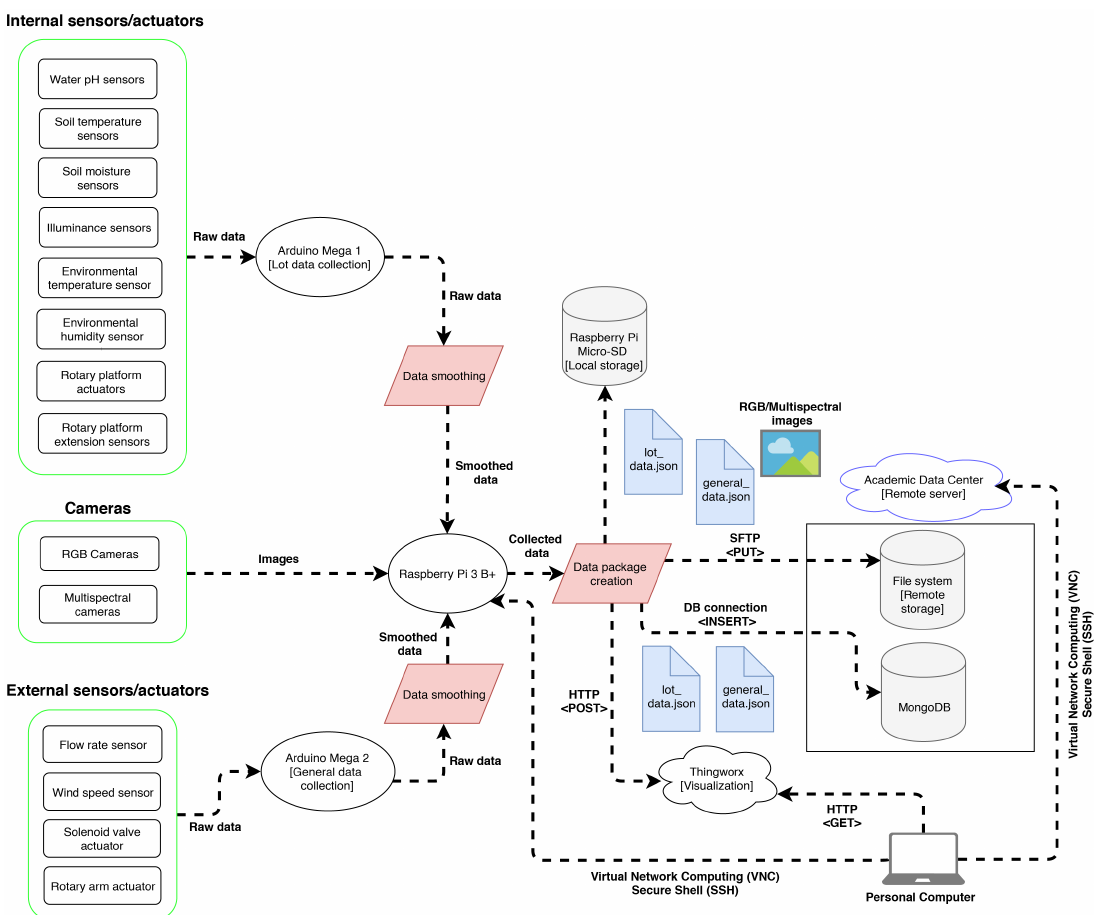
Figure 4. Final design of the data collection system’s cybernetic